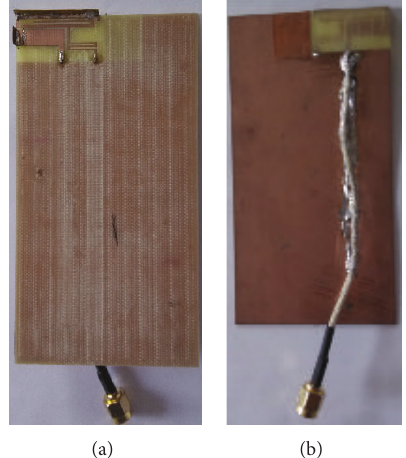
Figure 6: Photos of the fabricated antenna: (a) front side and (b) back side.